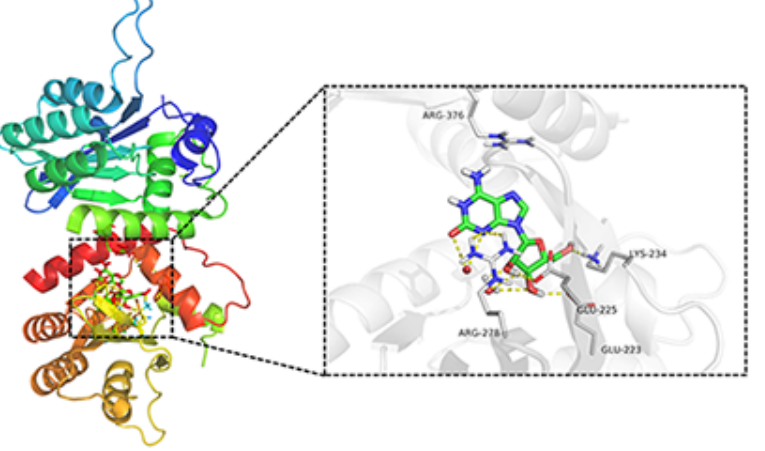
Figure 6. Molecular docking studies of crotonoside and APOBEC3G (PDB: 3V4K) at the binding site. 2.6. Crotonoside Can Inhibit the Viability of Different AML Cell Lines.